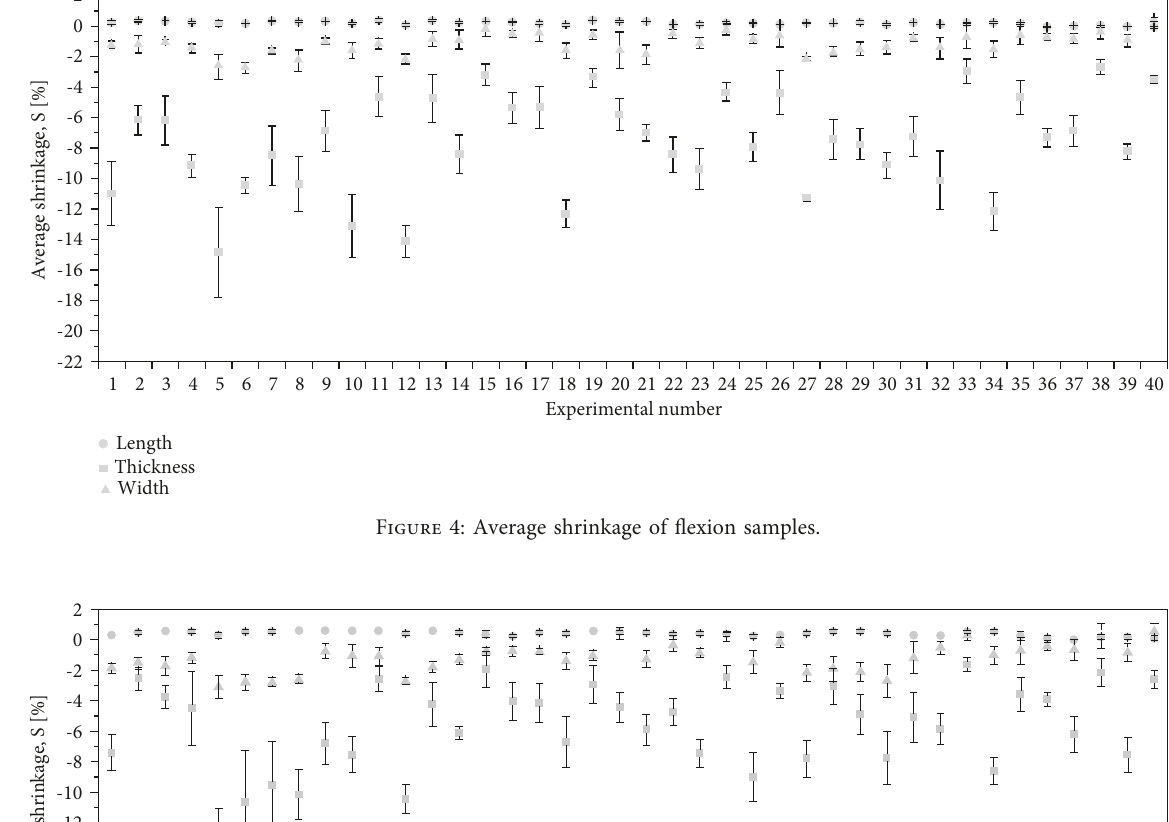
Figure 5: Average shrinkage of tensile